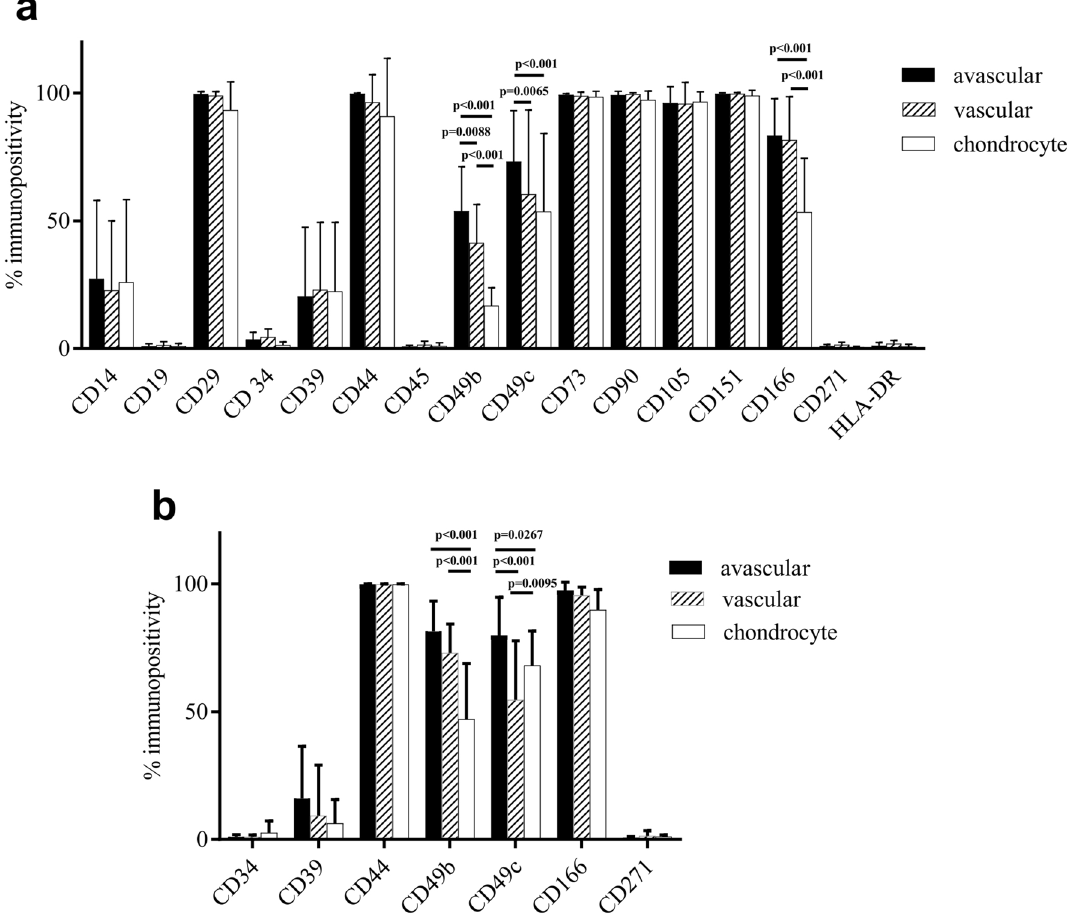
Figure 5. ( a ) Meniscal cells and chondrocytes exhibited similar immunopositivity for most of the markers investigated at passage 0. A greater percentage of meniscal cells were positive for CD49b, CD49c and CD166 compared with chondrocytes (10 donors); ( b ) A similar pattern was found for CD49b and CD49c immunopositivity across the cell types at passage 2 (6 donors). Data shown are the means ± the standard